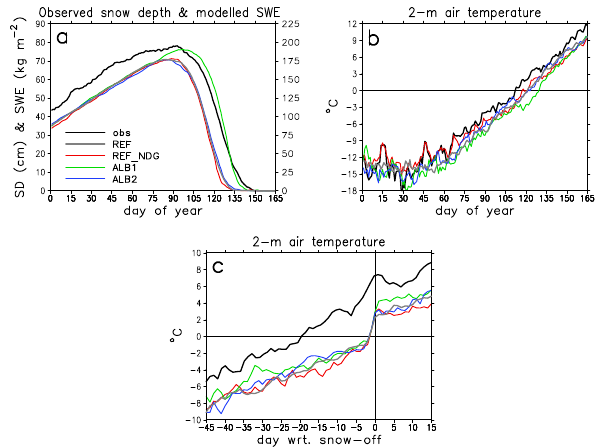
Figure 14. Comparison of ECHAM5 simulations with observations at Sodankylä (67.37 ◦ N, 26.63 ◦ E). (a) Mean seasonal cycle of ob- served snow depth (black line, scale on the left) and modelled SWE (four curves for different ECHAM5 experiments, scale on the right) in 1979–2006. (b) Mean seasonal cycle of 2m air temperature. (c) Mean 2m air temperature composited with respect to the snow- off date, “day 0” representing the first completely snow-free day. The ECHAM5 results are taken from the grid point nearest to the Sodankylä site (68.08 ◦ N, 26.25 ◦